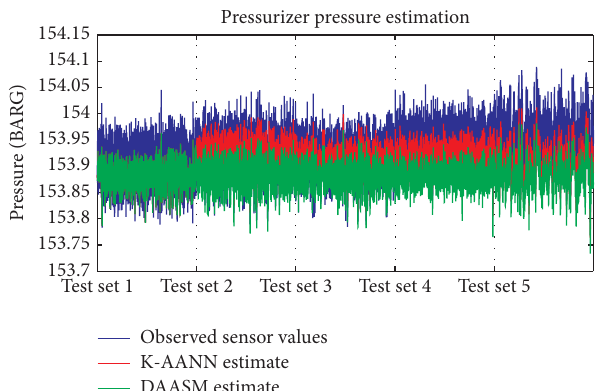
Figure 21: Pressurizer pressure estimates against drift failure up to 0.1%.